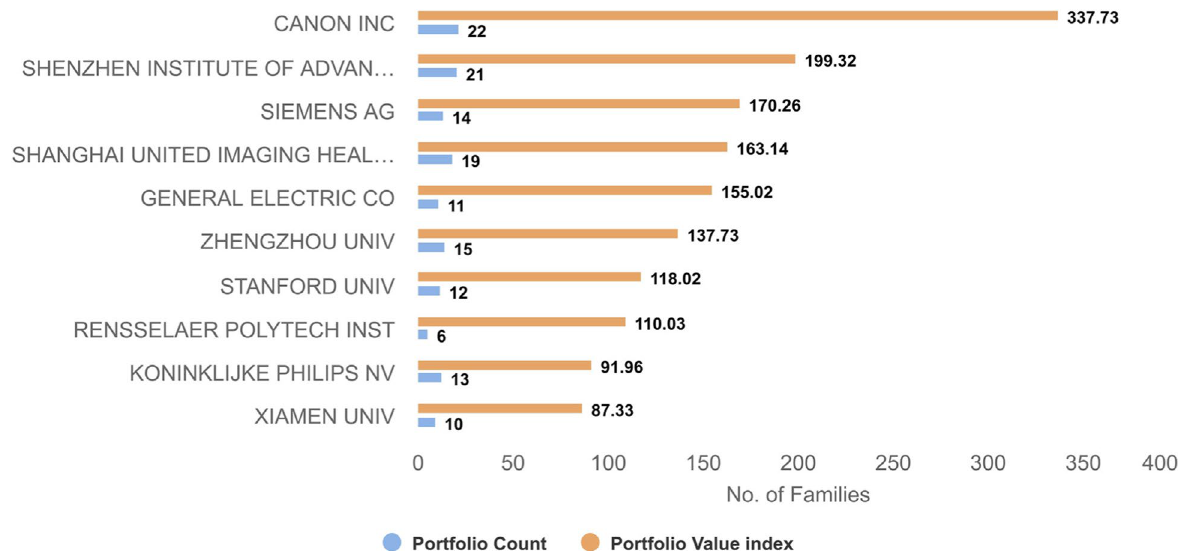
Fig. 6 Most valuable portfolios (benchmarked by PatSeer’s 360 0 score) showing top players with the highest portfolio value